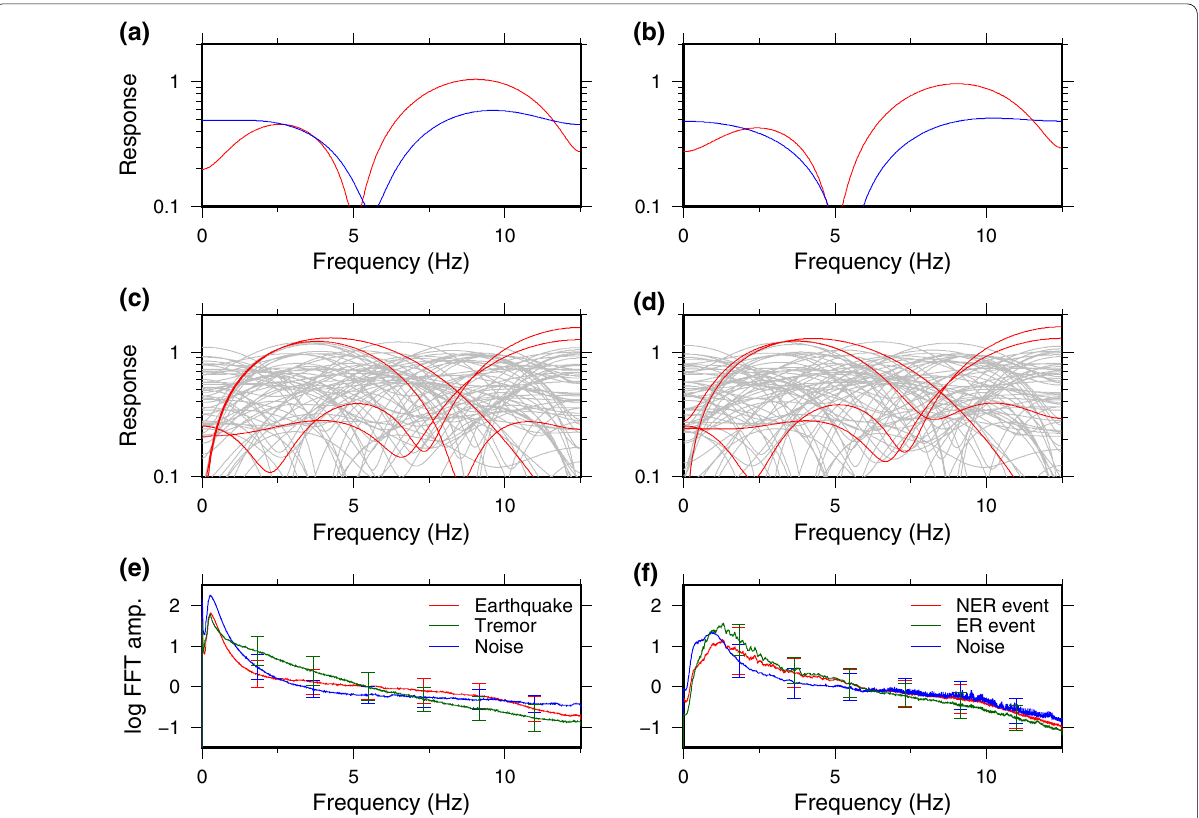
Fig. 3 FIR filter responses in the first convolutional layer and average spectra of each signal class. a , c , e Nankai and b , d , f Sakurajima datasets. FIR filter response curves are computed from the weights of a , b the two channels in the first convolutional layer of 1D CNN model 3 and c , d the 64 channels in the first layer of 1D CNN model 1 (see Table S2). In a , b red and blue lines indicate response curves for the first and second channels, respectively. In c , d response curves for channels with the four largest amplitudes are shown by red lines, and other channels by gray lines. e , f Average spectra of each signal